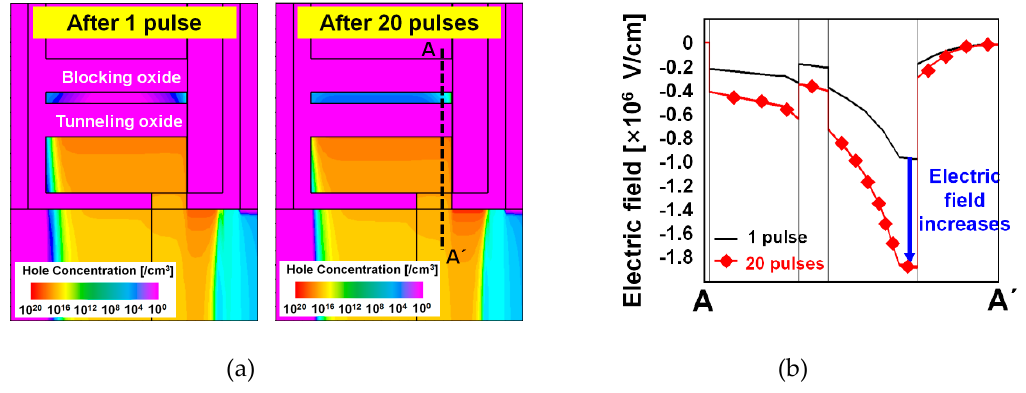
Figure 6. Pulse-number-dependent carrier distribution and electric field. ( a ) Distribution of hole concentration in the SFG and nitride charge-trap layer and ( b ) electric field along the cutline A-A’ in ( a ) after 1 and 20 potentiation pulses.